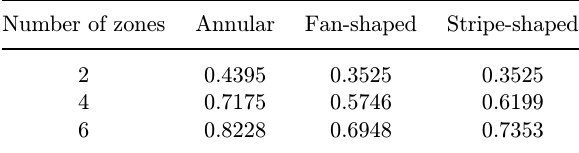
Table 1. Modulation